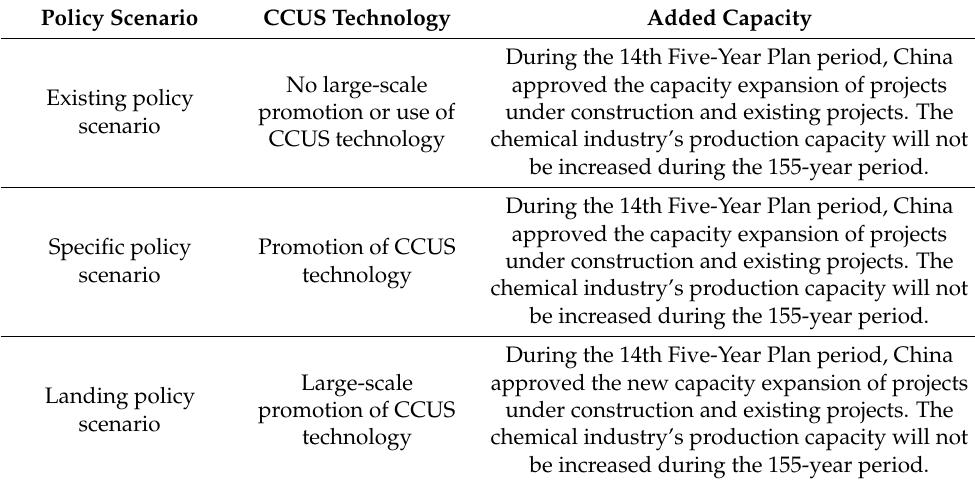
Table 1. Future development scenarios for the chemical industry.